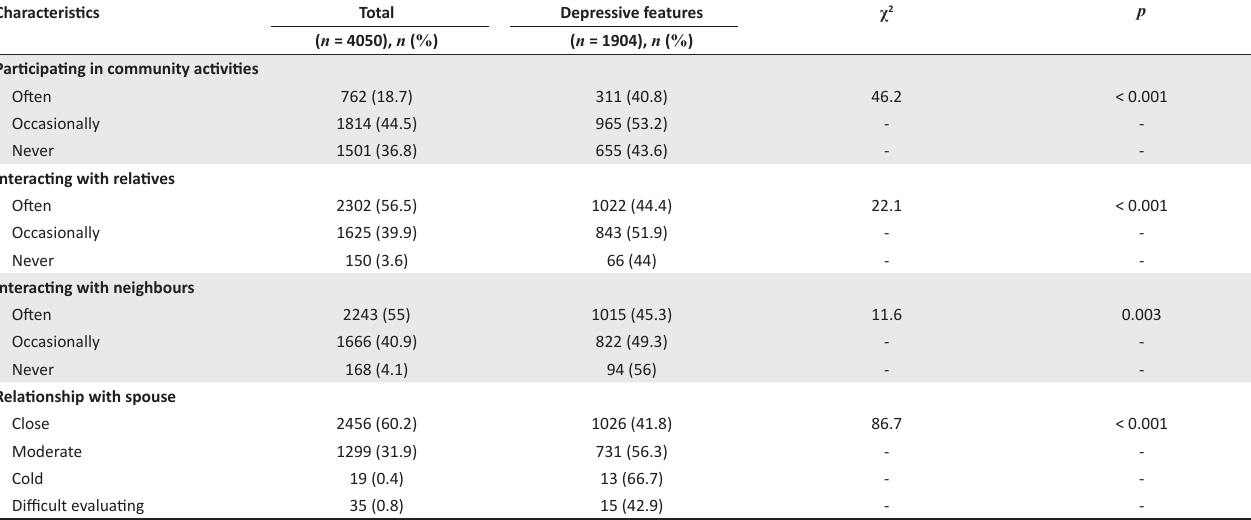
TABLE 3: Comparison of social interaction and family relationship of the elderly by depressive features.